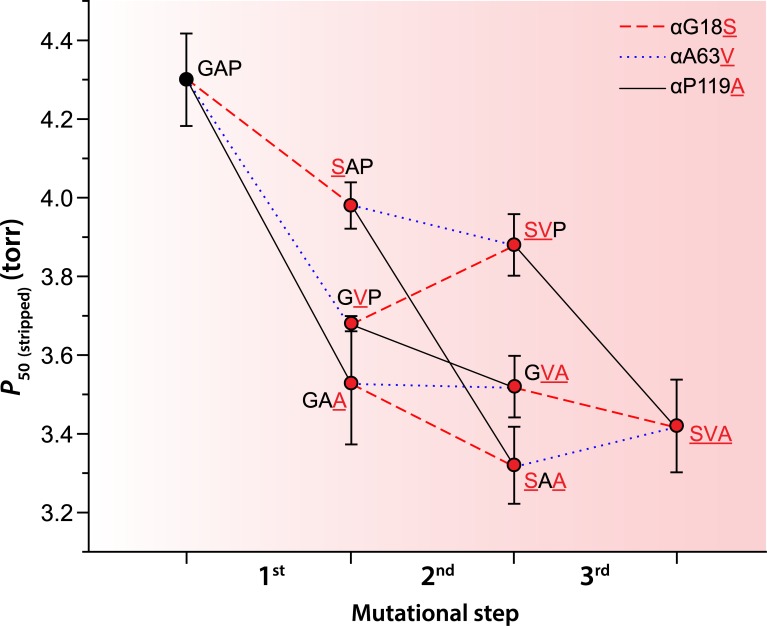
Trajectories of change in intrinsic Hb-O2 affinity (indexed by P50, torr) in each of six possible forward pathways that connect the ancestral ‘AncAnser’ genotype (GAP) and the wildtype genotype of bar-headed goose (SVA).Derived amino acid states are indicated by red lettering. Error bars denote 95% confidence intervals.